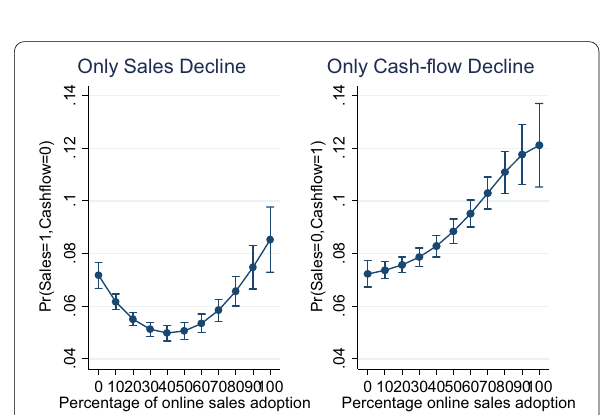
Fig. 3 Predictive margins plot of sale and cash-flow decline in isolation. Source : authors’ construct based on Covid-19 ES follow-up survey